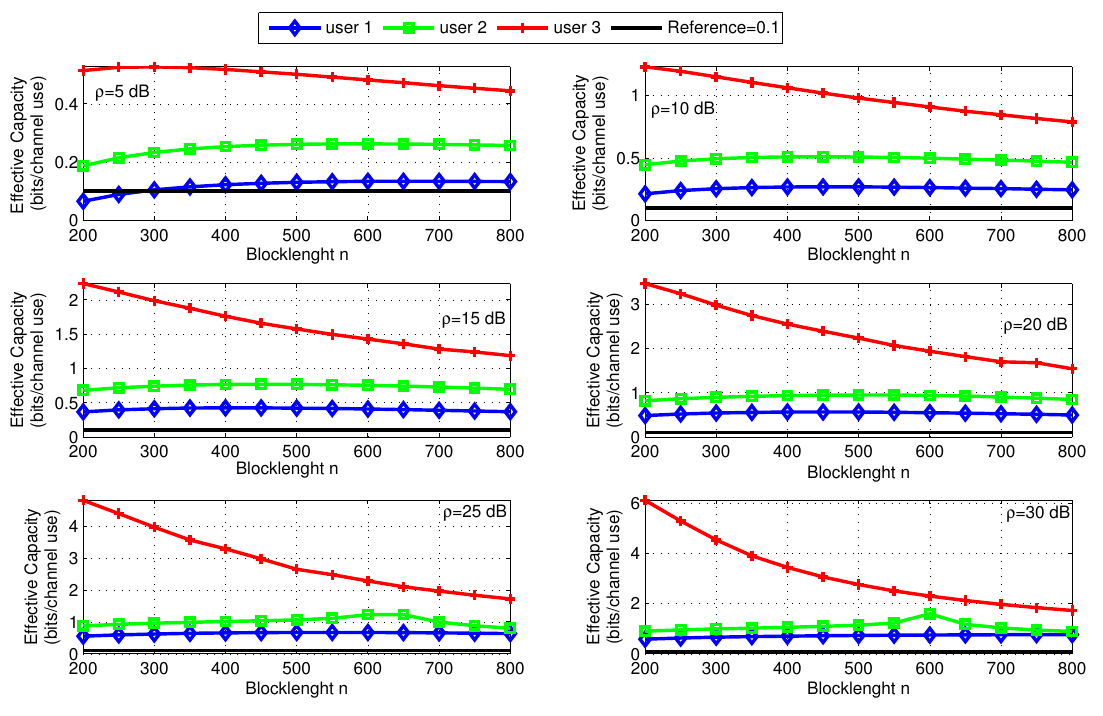
Figure 6. Effective capacity vs. the transmit SNR vs. the blocklength n, with θ 1 = θ 2 = θ 3 = 0.01, and ε = 10 − 5 .